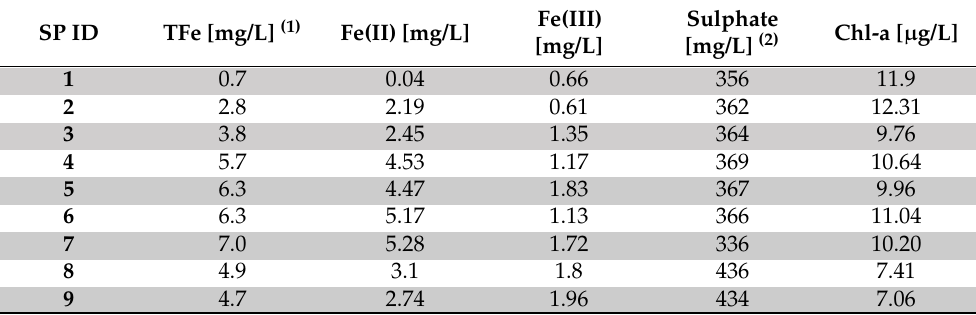
Table 1. List of the in situ monitored chemical parameters. The SP-IDs 3-14 and 16-18 were used for the derivation models. Thus, the total quantity (N) ranged between 13 and 15 values. This was due to suitable spatial overlaying with the RS